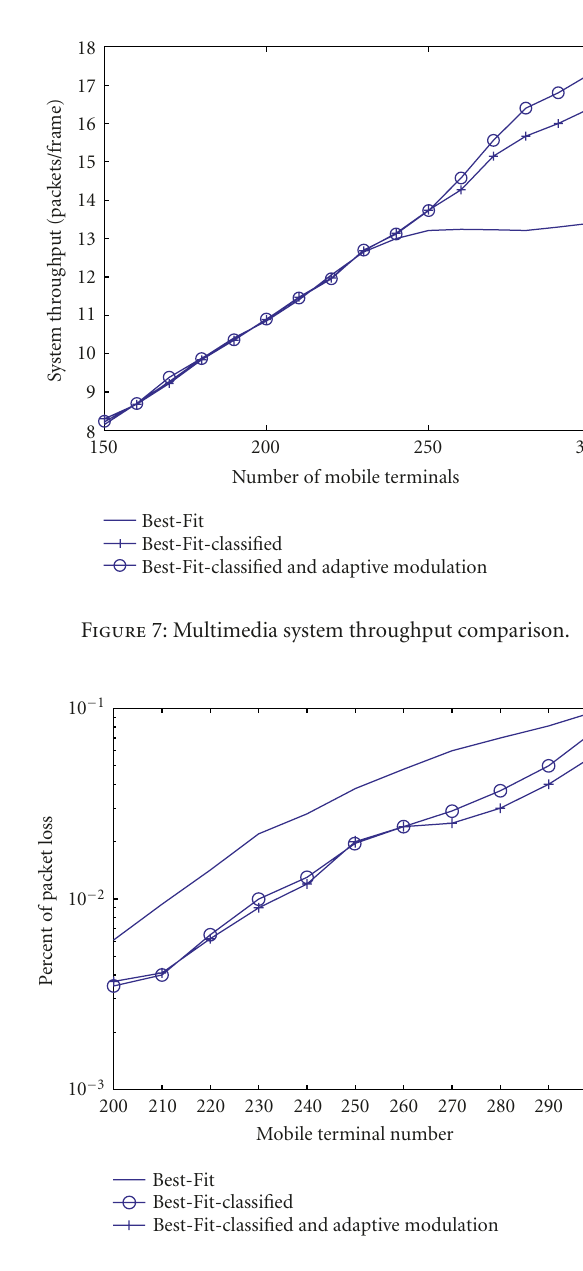
Figure 8: Packet loss rate